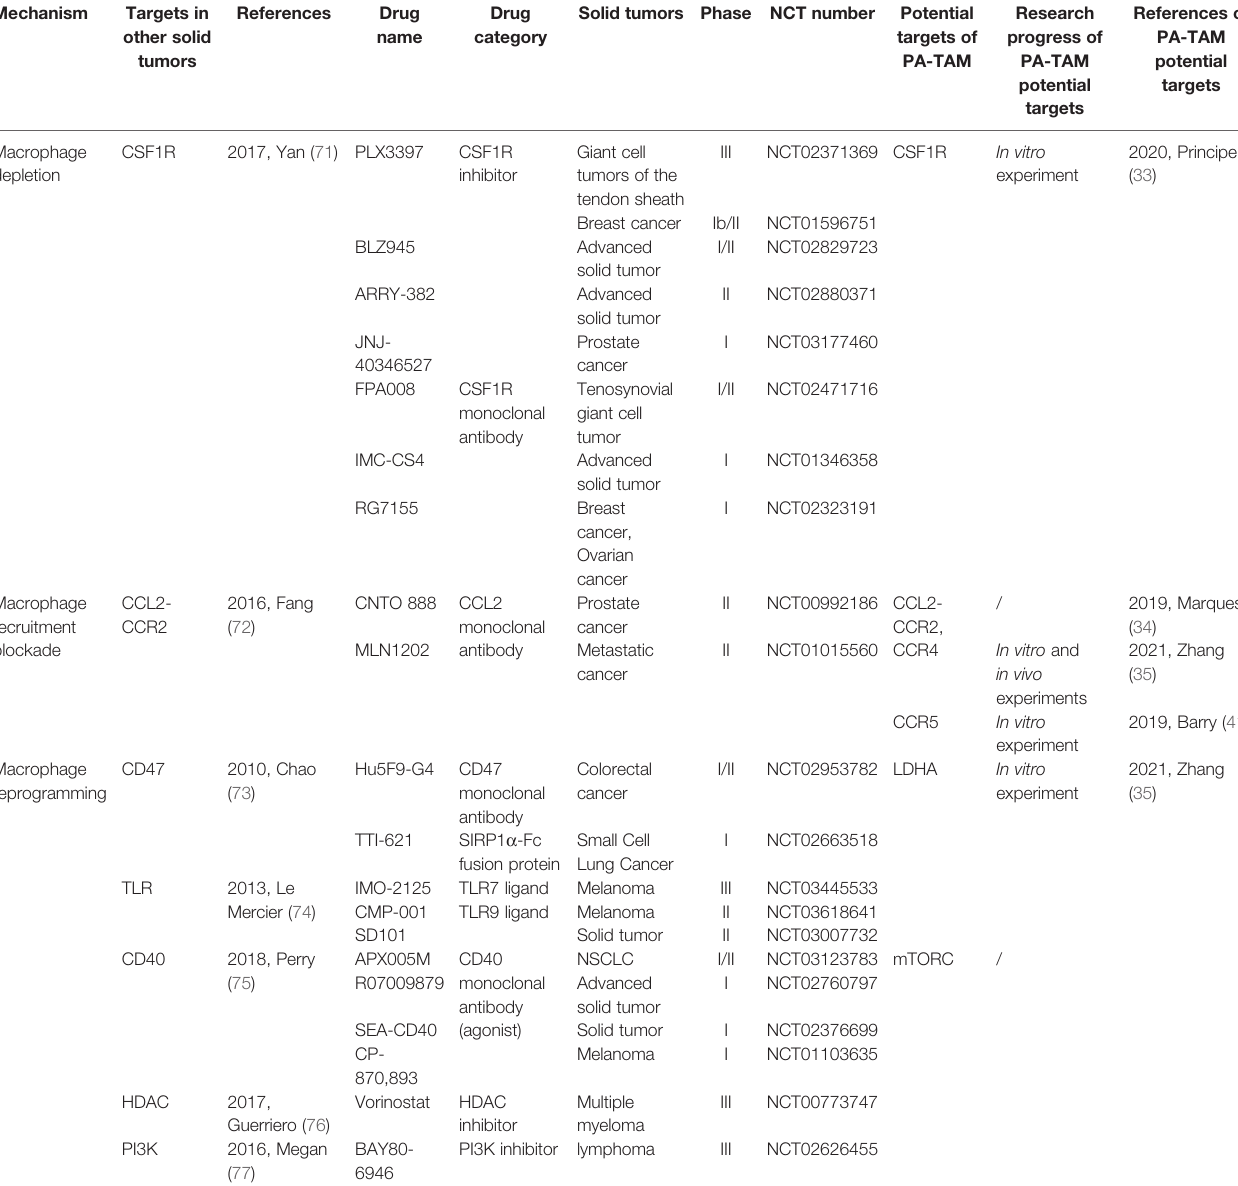
TABLE 1 | The mechanisms, corresponding drugs, the potential targets in PAs and relevant information of macrophage targeted therapy.